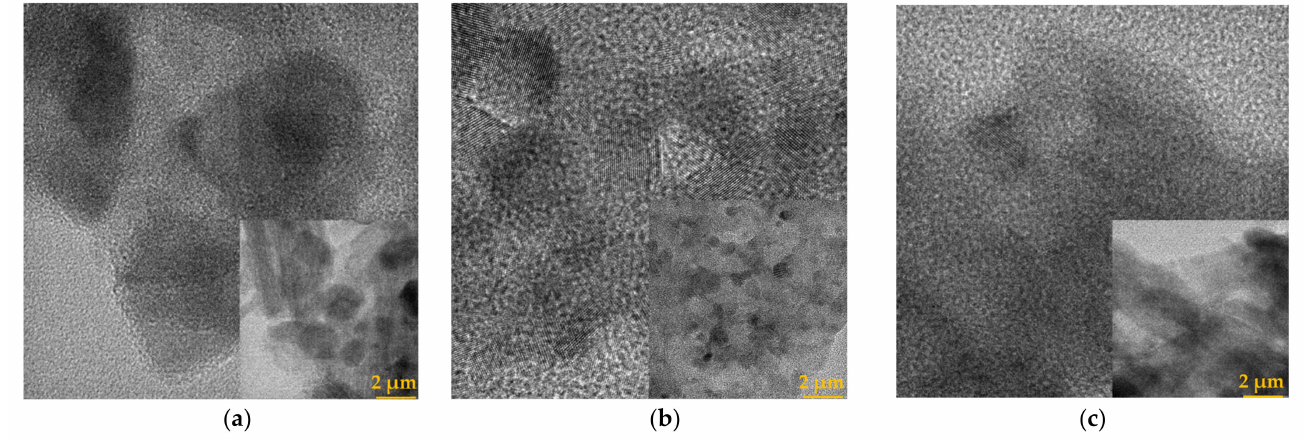
Figure 4. TEM images of catalysts (scale = 2 µ m & 500 nm): ( a ) Fe 0.8 Cu 0.2 /RHA; ( b ) Fe 0.67 Cu 0.33 /RHA; ( c ) Fe 0.5 Cu 0.5 /RHA.